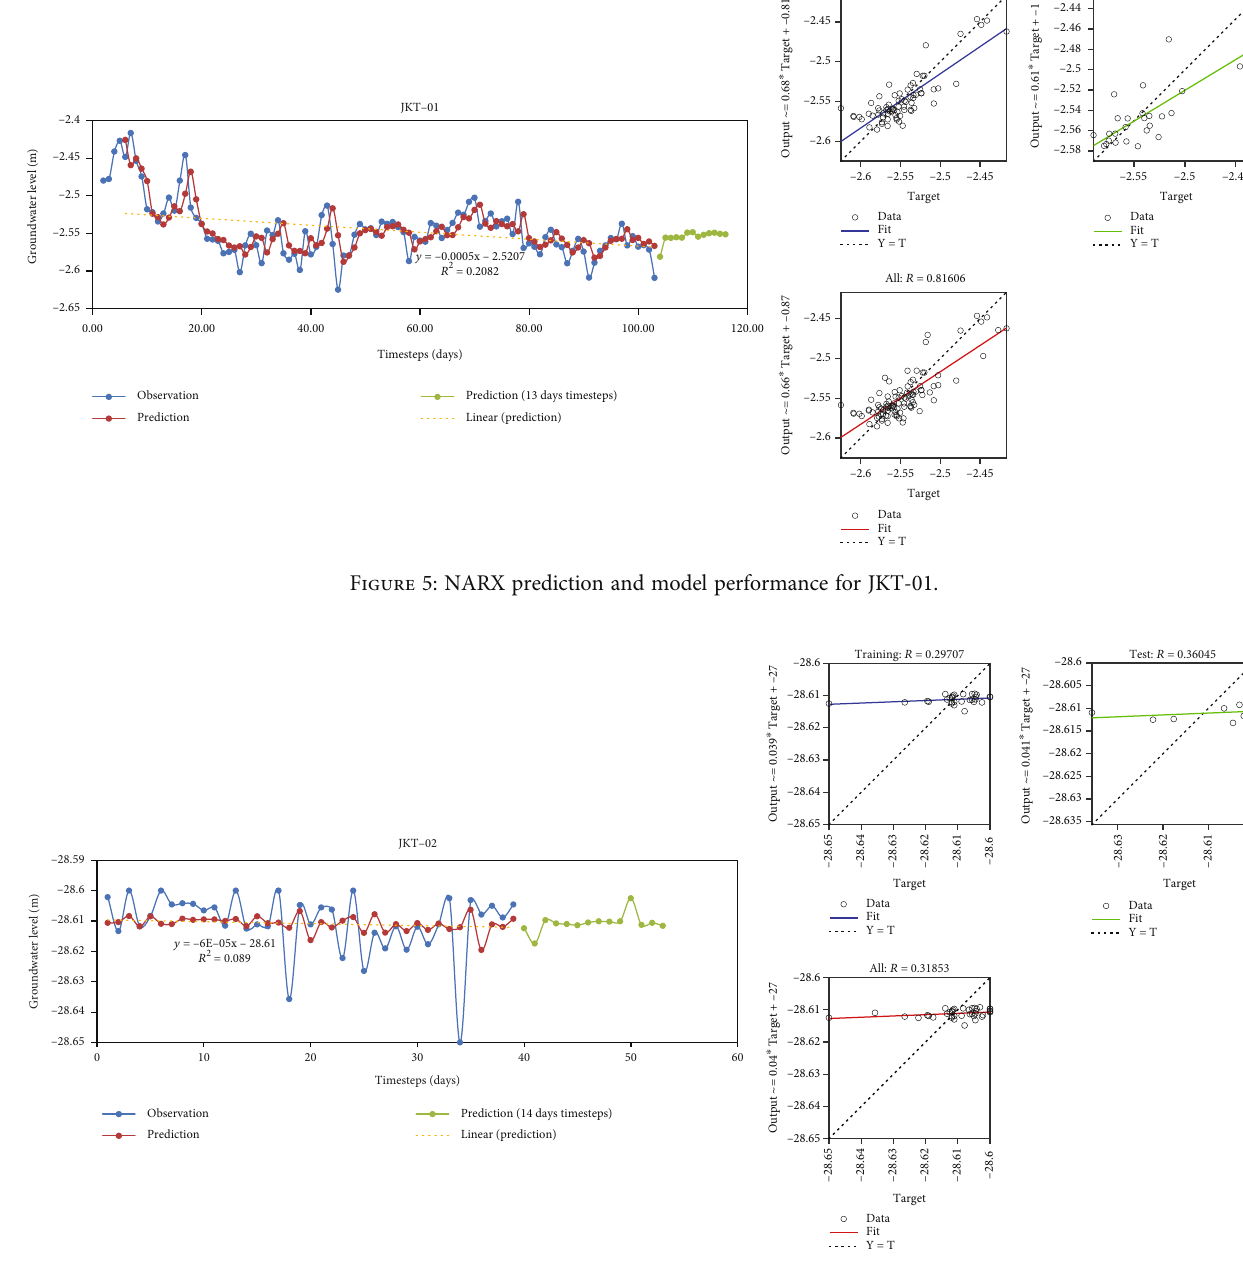
Figure 6: NARX prediction and model performance for